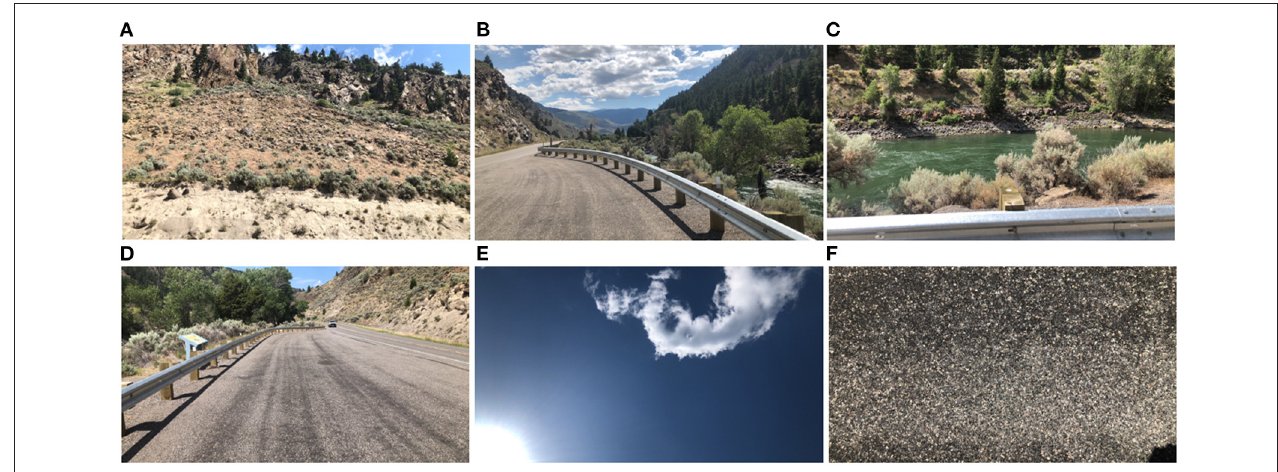
FIGURE 9 | Sample GLOBE Observer land cover photos: (A) North, (B) East, (C) South, (D) West, (E) Up, and (F) Down.